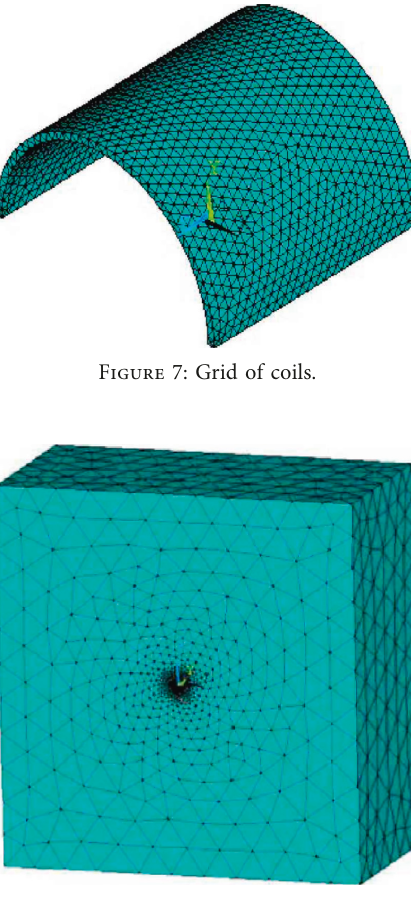
Figure 8: Overall grid with air. intensity of the transmitting coil is maximum is shown in Figure 11. From the magnetic field intensity around the coil, it can be seen that the current is generated in the resonant coil at the receiving end.